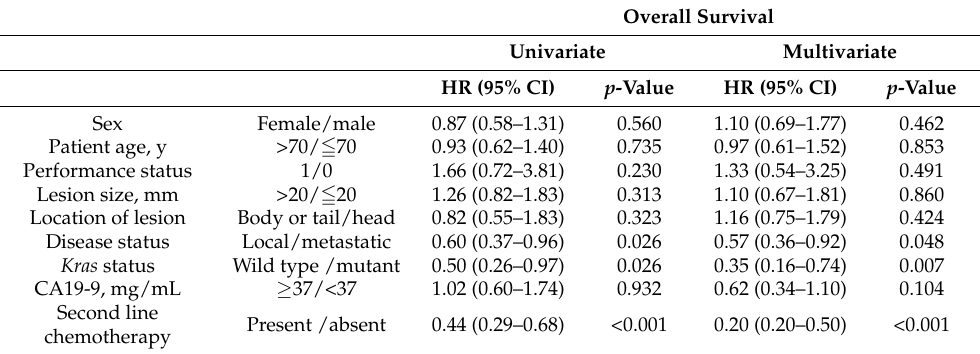
Table 4. Univariate and multivariate analyses of prognostic factors with progression-free survival. Table 5. Univariate and multivariate analyses of prognostic factors associated with overall